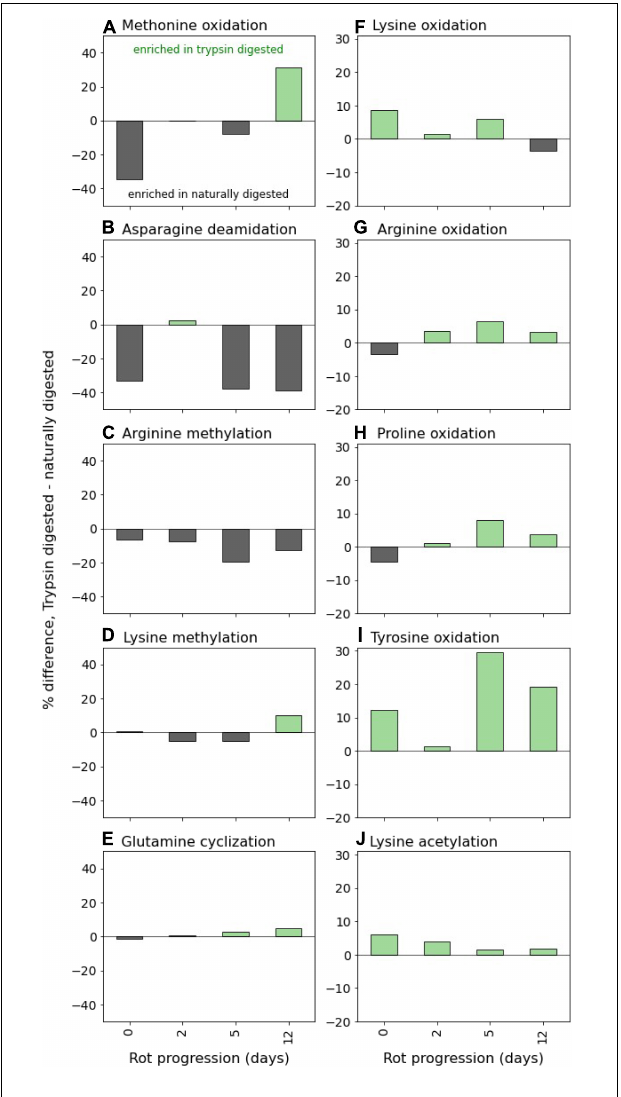
FIGURE 4 | Post-translational modifications (PTMs) of algal peptides at four time points along the 12-day incubation. Shown are the difference between trypsin-digested naturally digested peptides for the 10 variable modifications included in the database searches and de novo sequencing parameters, which were selected from preliminary open modification searches of the mass spectral data (see section “Materials and Methods”): (A) methionine oxidation, (B) asparagine deamidation, (C) arginine methylation, (D) lysine methylation, (E) glutamine cyclization (pyro-glutamation), (F) lysine oxidation, (G) arginine oxidation, (H) proline oxidation, (I) tyrosine oxidation, and (J) lysine acetylation. PTM distributions are expressed as the differences in percent of residue modification in the entire peptide pool (database and de novo sequences) as corrected by relative peptide area abundance. Thus, positive values indicate the PTM is relatively enriched in the trypsin-digested peptides, and negative values mean the PTM is relatively enriched in the naturally digested peptides. Bacterial peptides were not included in the PTM analysis. Y-axis scales are the same between columns (A–J)